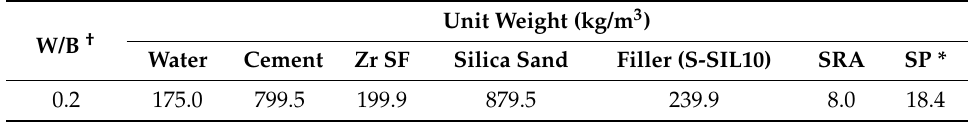
Table 1. Mixture